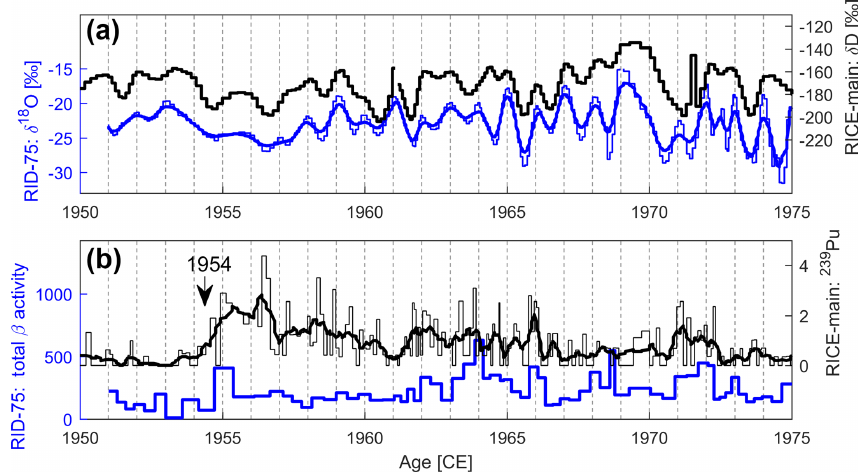
Figure 5. (a) RICE water isotope profile ( δ D) compared to isotope data ( δ 18 O) from the RID-75 core for the period 1950–1975. Diffusion causes the isotope record to smooth over time, and a smoothed version of the RID-75 isotope profile (thick blue) highlights its similarities to the RICE isotope record (black). (b) Total specific β activity (in disintegrations per hour, dph) for the RID-75 core compared to 239 Pu measurements (normalized intensities) from the RICE main core. Both cores show a sharp increase in nuclear waste deposition starting in 1954CE and several broader peaks